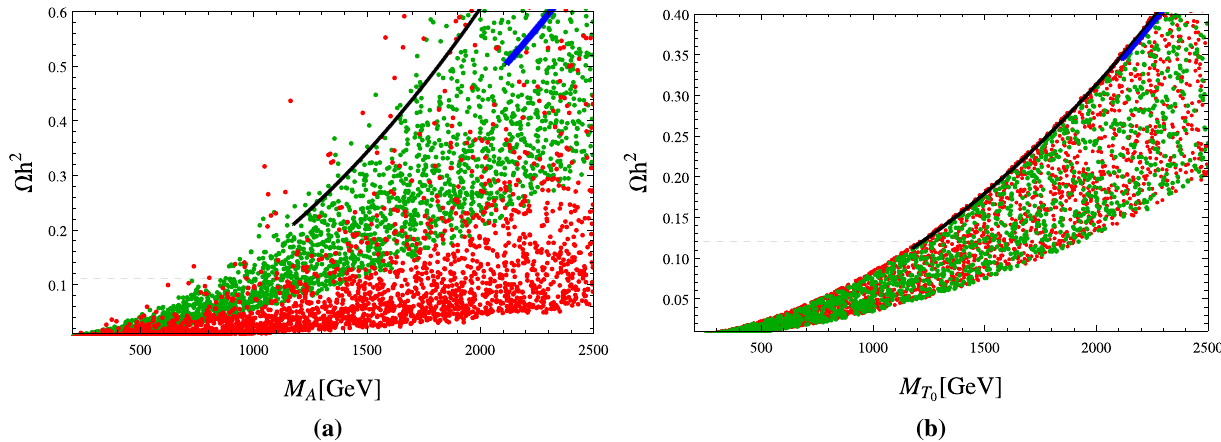
Fig. 16 Relic density vs dark matter mass in GeV. a Inert Higgs Dou- blet Model; b Inert Higgs Triplet Model. Red color corresponds to the electroweak symmetry breaking allowed points, Green color cor- responds to the points which are allowed by both perturbativity and